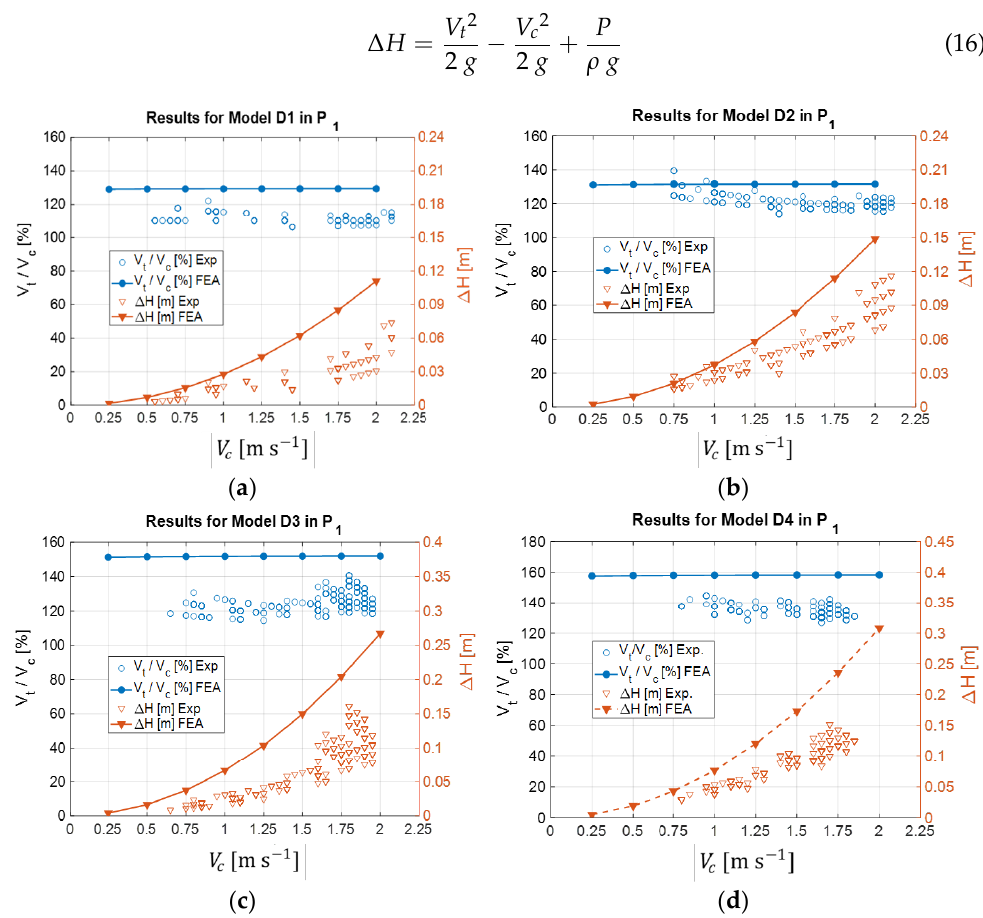
Figure 15. Ratio 𝑉 𝑡 𝑉 𝑐 ⁄ and ∆𝐻 from experimental and FEA results for models D1 ( a ), D2 ( b ), D3 Figure 15. Ratio V t / V c and ∆ H from experimental and FEA results for models D1 ( a ), D2 ( b ), D3 ( c ), ( c ), and D4 ( d ). and D4 ( d